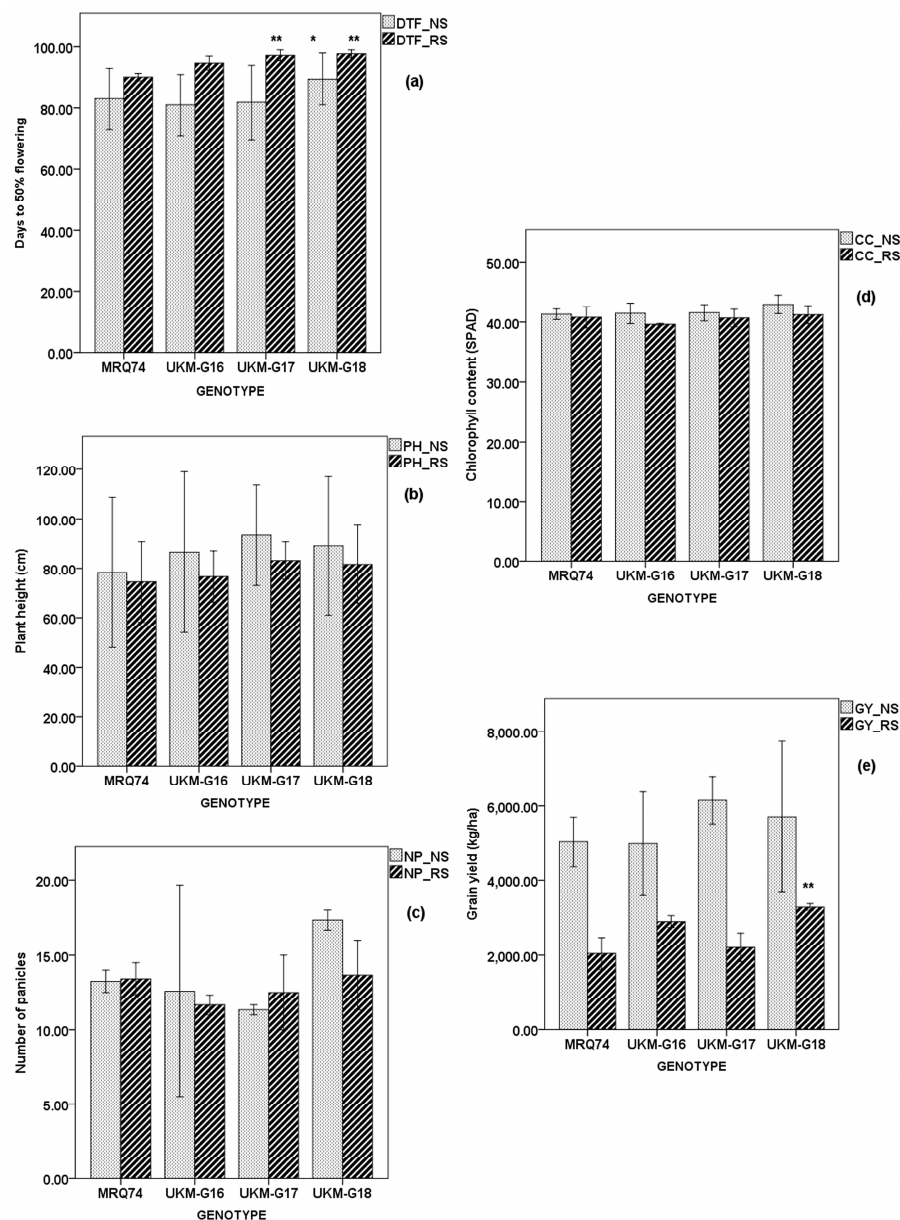
Figure 2. Average of mean of MRQ74 population for two seasons under NS and RS. ( a ) Days to 50% flowering, ( b ) Plant height (cm), ( c ) Number of panicles, ( d ) Chlorophyll content, ( e ) Grain yield (kg / ha). * Significant difference from MRQ74 under NS; p < 0.05, ** Significant difference from MRQ74 under RS; p < 0.05. Error bar: ± standard error (SE).